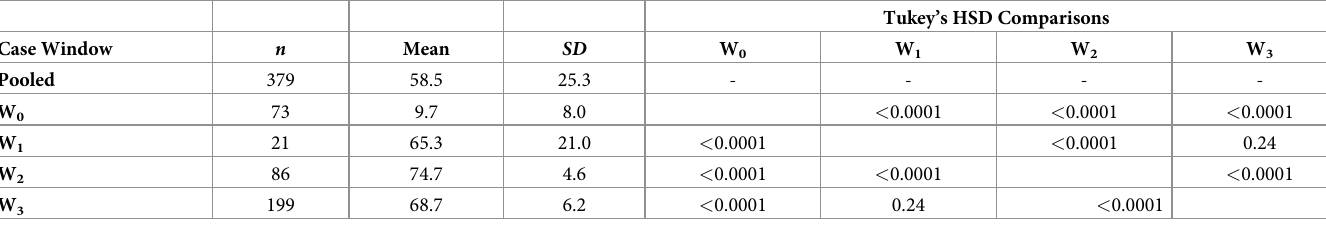
Table 7. One-way analysis of variance of the containment and health index by case window,